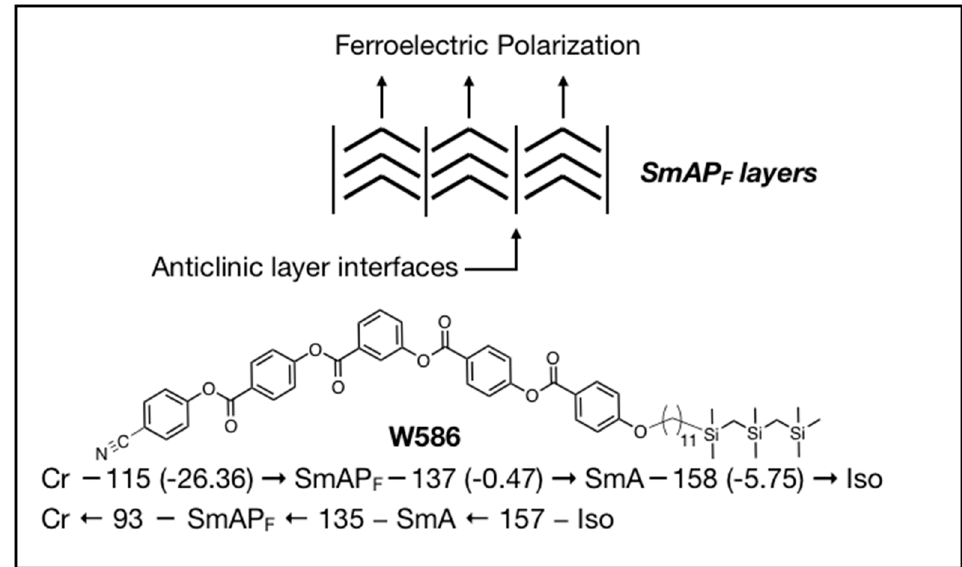
Figure 1. The chemical structure, phase sequence, transition temperatures (°C), and transition enthalpies (heating, kJ/mol) of W586 , with an illustration of the SmAP F layer structure showing the anticlinic layer interfaces leading to ferroelectric order in the bent-core SmAP F phase.